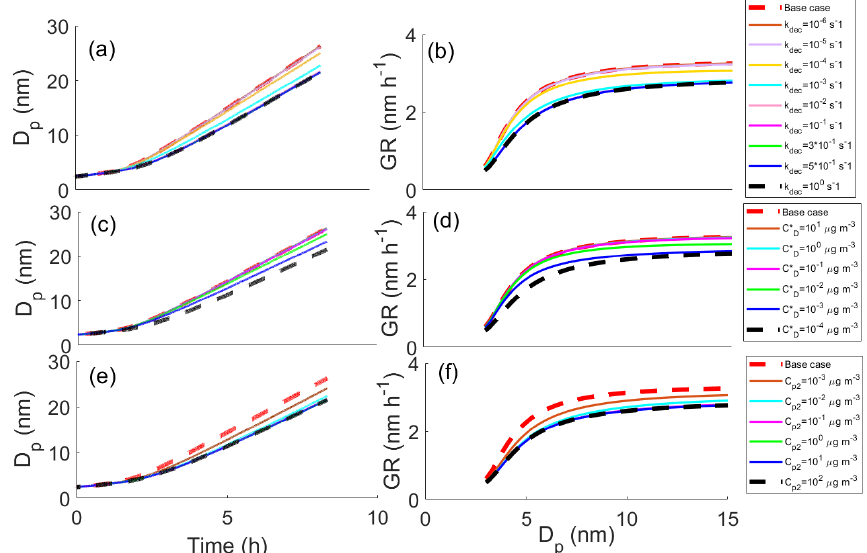
Figure 3. The diameter of the particle ( D p ) as a function of time and growth rate (GR) of the particle as a function of diameter in simulations, in which one model compound is allowed to decompose into two smaller compounds, (a, b) for simulations with different decomposition rate coefficients, (c, d) for simulations with different saturation concentrations of decomposing compounds ( C ∗ ) and (e, f) for simulations with D different saturation concentrations of one of the decomposed product compounds ( C ∗ ). Except for the parameter that was varied, values p , 2 = 10 − 4 µgm − 3 , C ∗ = 10 2 µgm − 3 and the saturation concentration of the other product compound were as follows: k dec = 1s − 1 , C ∗ D p , 2 = 10 2 µgm − 3 . These parameter values correspond to the simulation with the slowest growth among the Case 1 simulations which is C ∗ p , 1 present in every panel as a dashed black line. The base case simulation in each panel describes simulation without decomposition reaction.